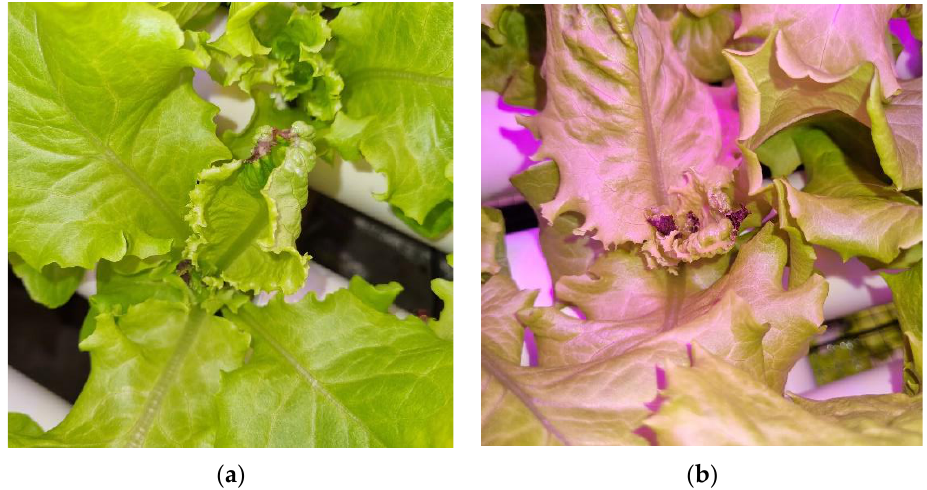
Figure 1. Example of captured images of tip-burn lettuce: ( a ) under white LEDs; ( b ) under red/blue